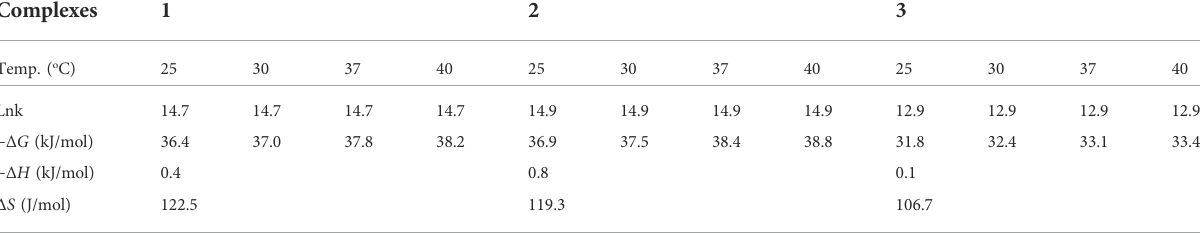
TABLE 1 Thermodynamic parameters of the synthesised complexes.